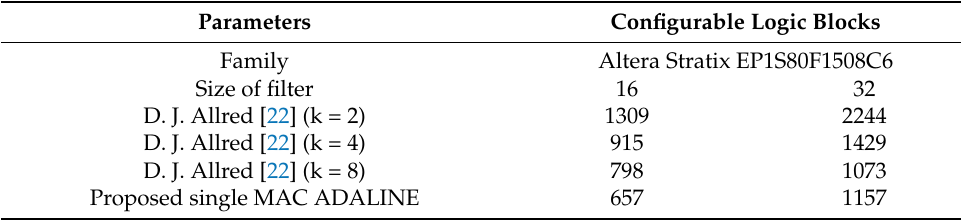
Table 3. Synthesis comparison of MAC LMS filter with existing architecture.